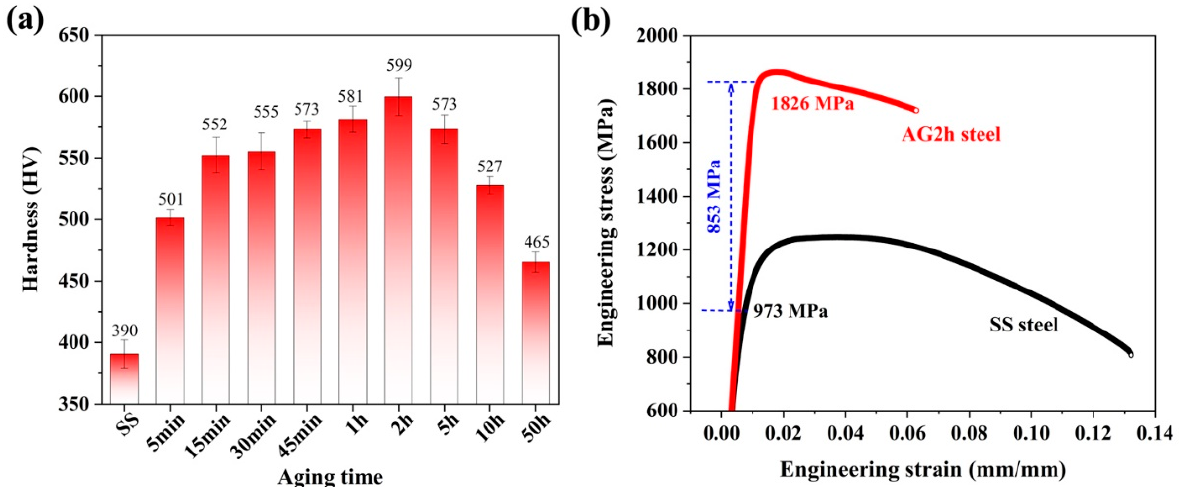
Figure 1. ( a ) Microhardness evolution of the steel aged at 500 °C for different periods. ( b ) Room- temperature tensile stress–strain curves for the SS and AG2h steels. Table 2. Mechanical properties of the nanoprecipitate-strengthened steels with different Mn con- tents.